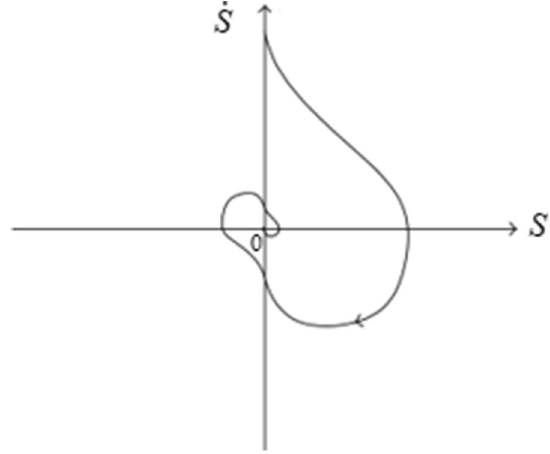
Fig. 8 Phase plane trajectory of STW